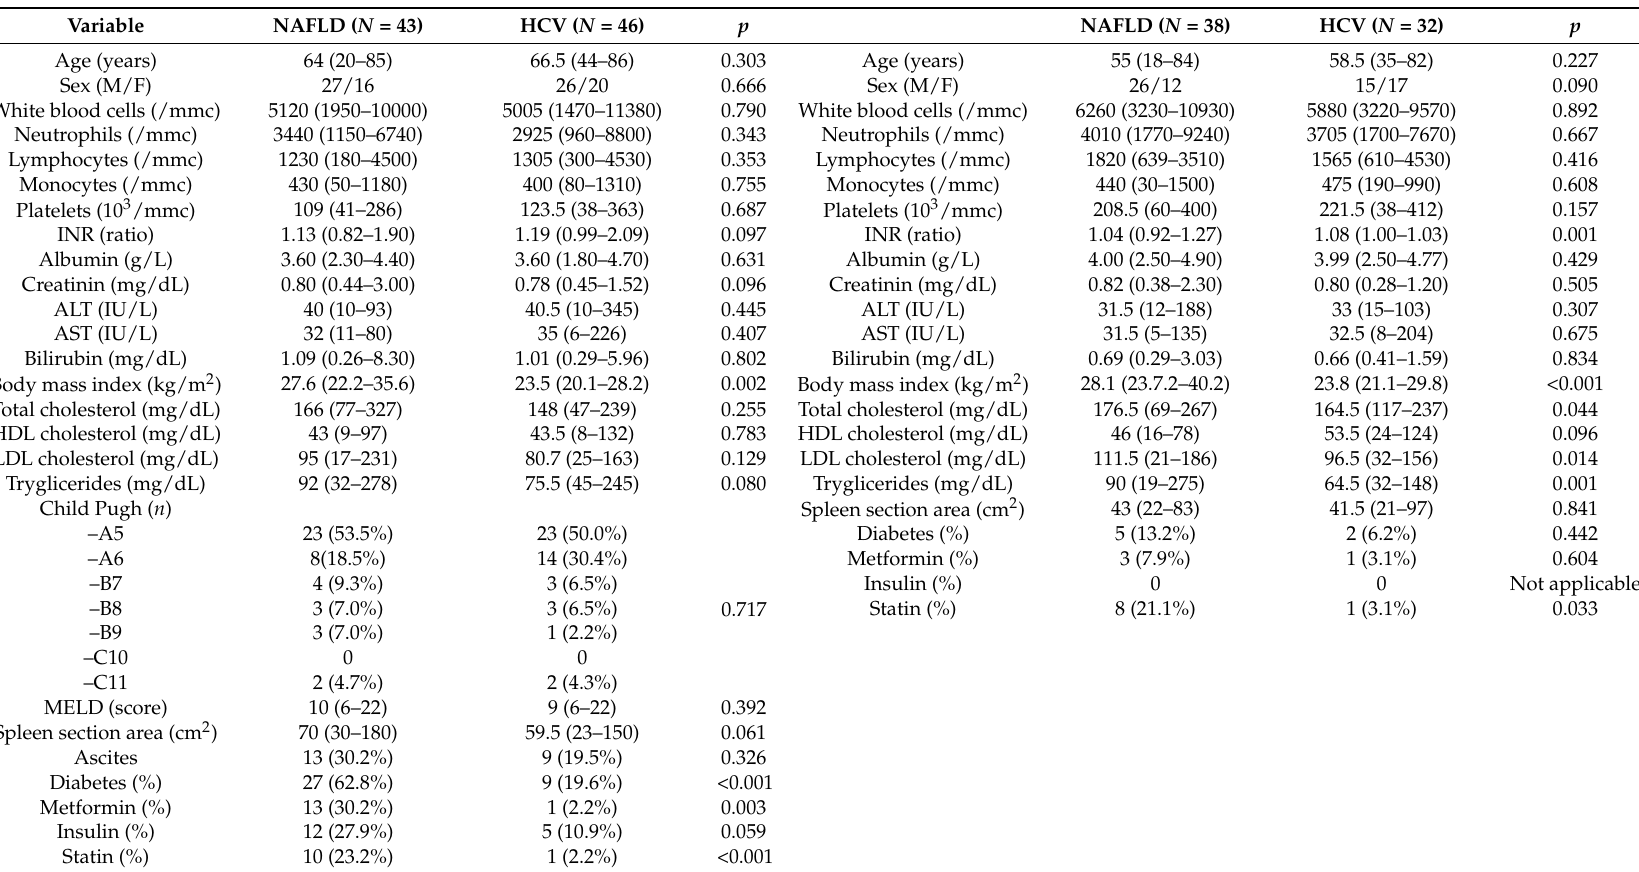
Table 3. Main demographic, clinical, and laboratory findings of patients with non-alcoholic fatty liver disease (NAFLD) and hepatitis C virus (HCV)-related chronic liver disease, divided according to the presence (left column) or the absence (right column) of liver cirrhosis. Continuous variables are expressed as median (range). Categorical variables are espressed as number of patients